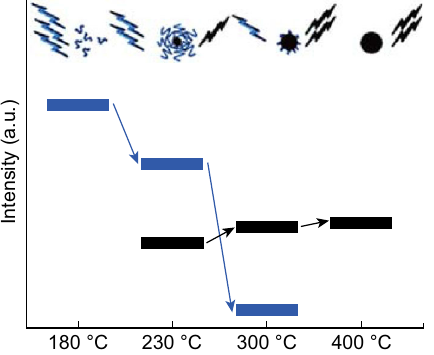
Fig. 12 Schematic representation of the emission properties of three photoactive species obtained from heat treatment of a citric acid and ethanolamine mixture. During heating, the organic fluorophores (blue groups) are consumed to build up the carbogenic core (black sphere) so that the PL component that corresponds to the carbogenic core (black bars) increases at the expense of the component from the organic fluorophores [95]. Copyright (cid:2) 2011 American Chemical Society. (Color figure